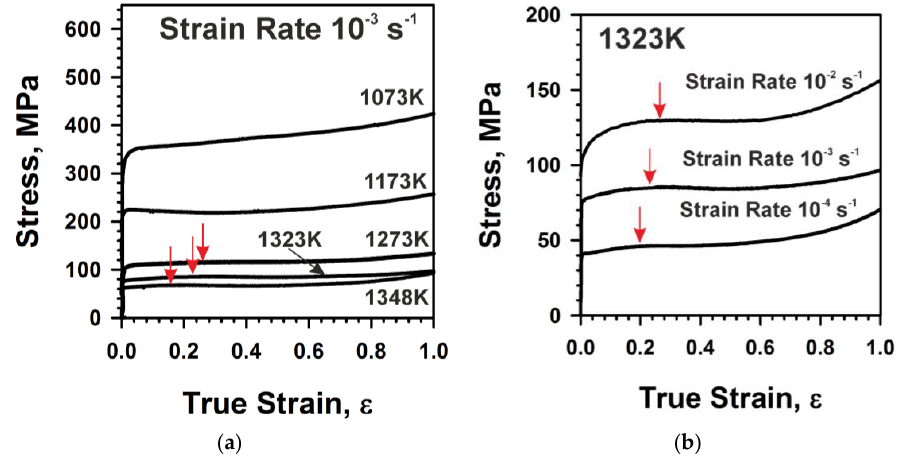
Figure 1. The true stress-true strain curves of the high nitrogen austenitic stainless steel under various deformation conditions, i.e., at strain rate of 10 −3 s −1 ( a ) and at a temperature of 1323 K. ( b ) The red arrows indicate the peak stress associated with DRX.